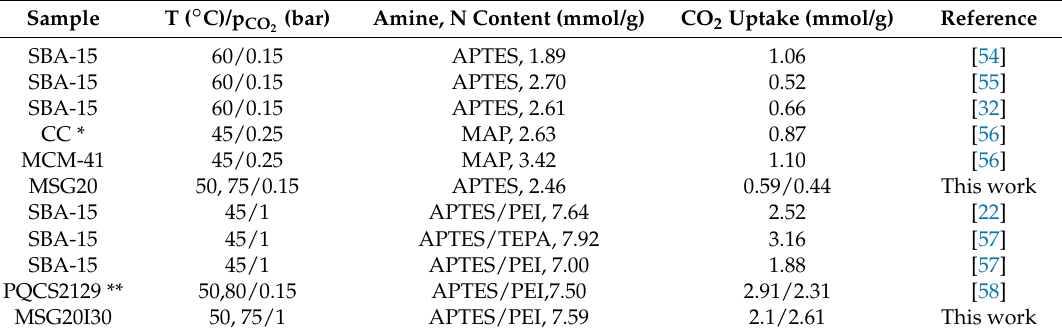
Table 6. Comparison of adsorption capacity of MSG60 and MSG20I30 with others similar ones found in the